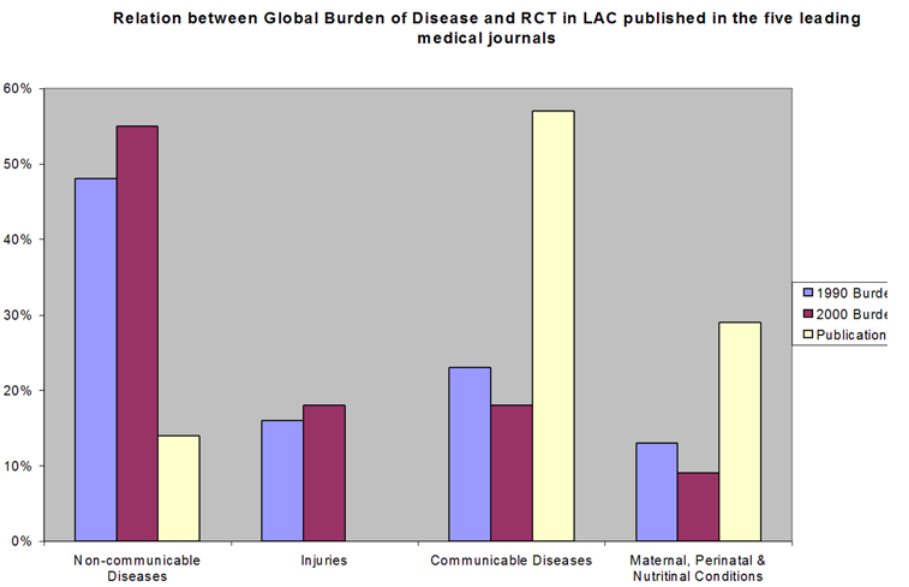
Figure 1. Relation between Global Burden of Disease and RCTs in LAC published in the five leading medical journals. The figure shows an evident mismatch: non-communicable diseases represented 48% of the burden of disease in LAC and 14% of the RCTs. No RCTs addressed injuries despite these representing 18% of the DALYs in 2000.